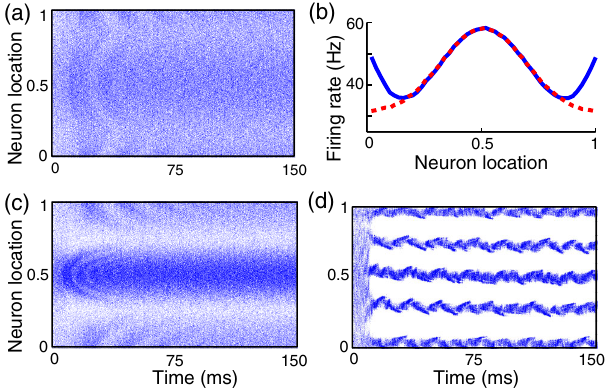
FIG. 6. Network simulations without periodic boundaries. (a) Raster plot of excitatory spike trains from a simulation identical to the simulation in Fig. 2(a) except that connection probability is computed without periodic boundaries (so that cells near the boundaries receive fewer recurrent inputs). (b) Firing rate profile of excitatory cells from (a) (solid blue curve) is similar to the firing rate profile from Fig. 2(a) (dashed red curve) except near the boundaries. (c) Same as (a) except σ